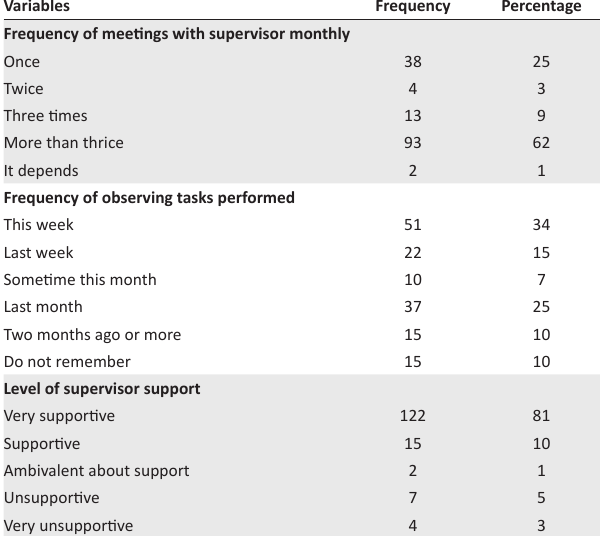
FIGURE 2: Duration of non-communicable disease-related training among community health worker ( n = 79). TABLE 2: In-service supervision and support ( n = 150).